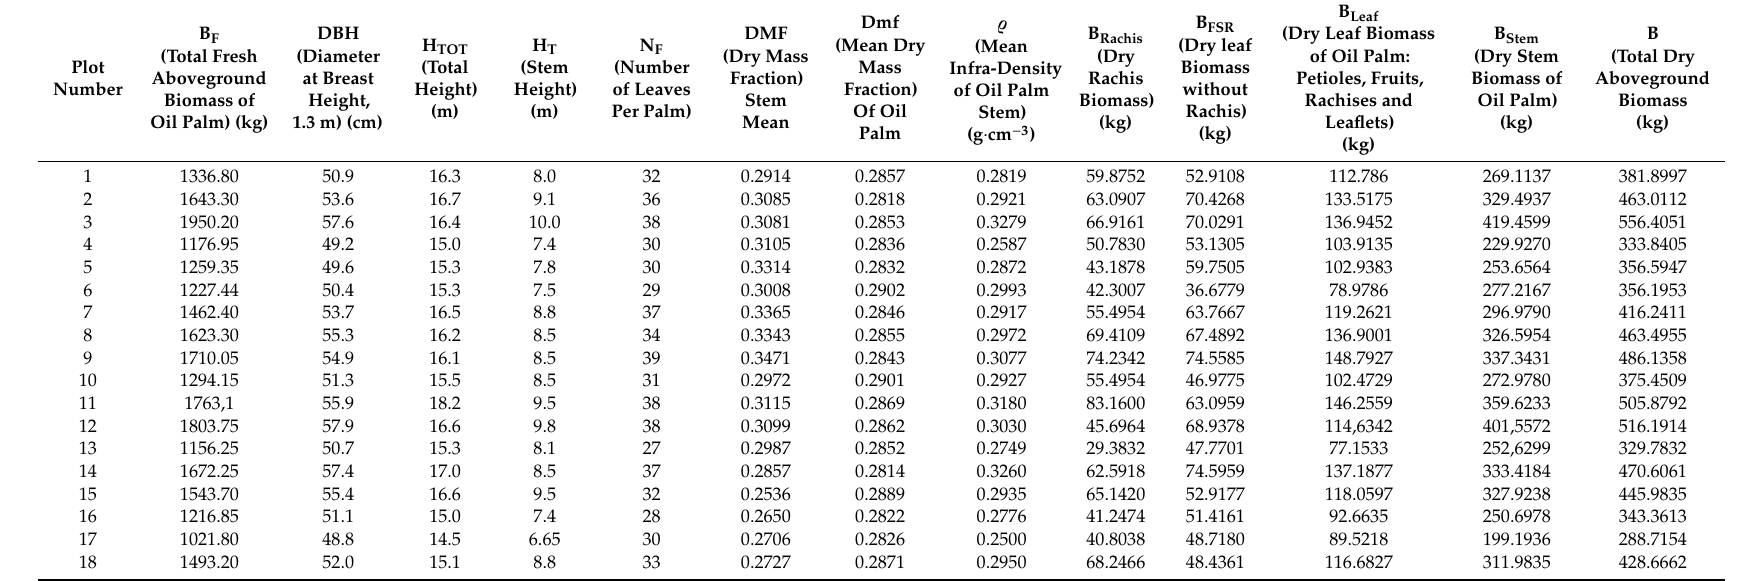
Table A1. Field and laboratory data that were used to develop aboveground biomass models for oil